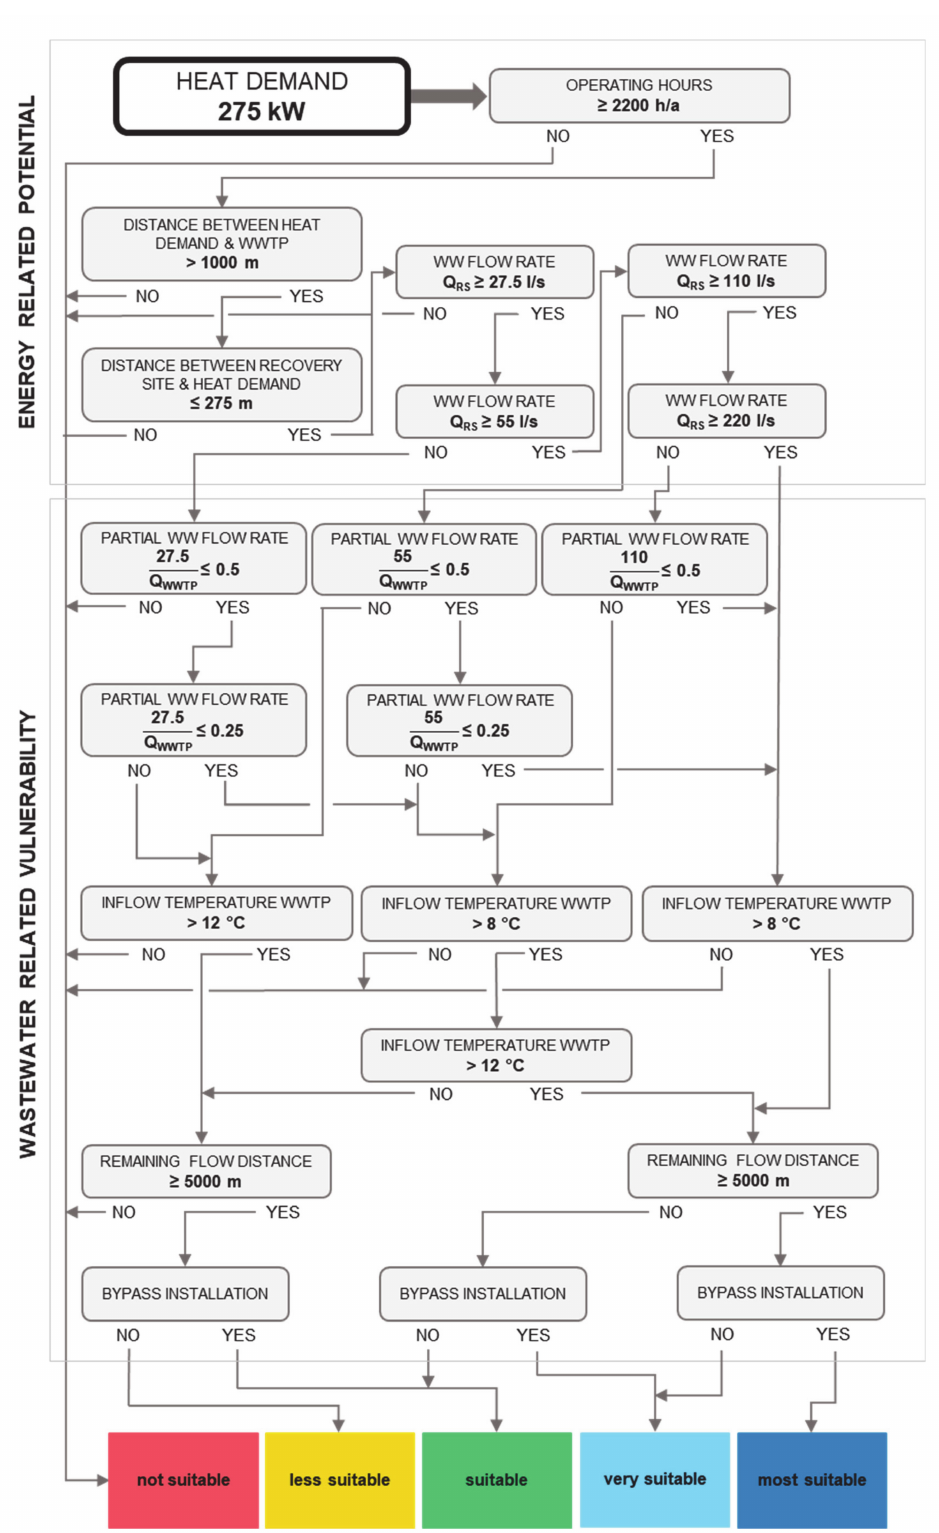
Figure A8. Relevance tree for an intended heat supply of 275 kW (own representation, based on